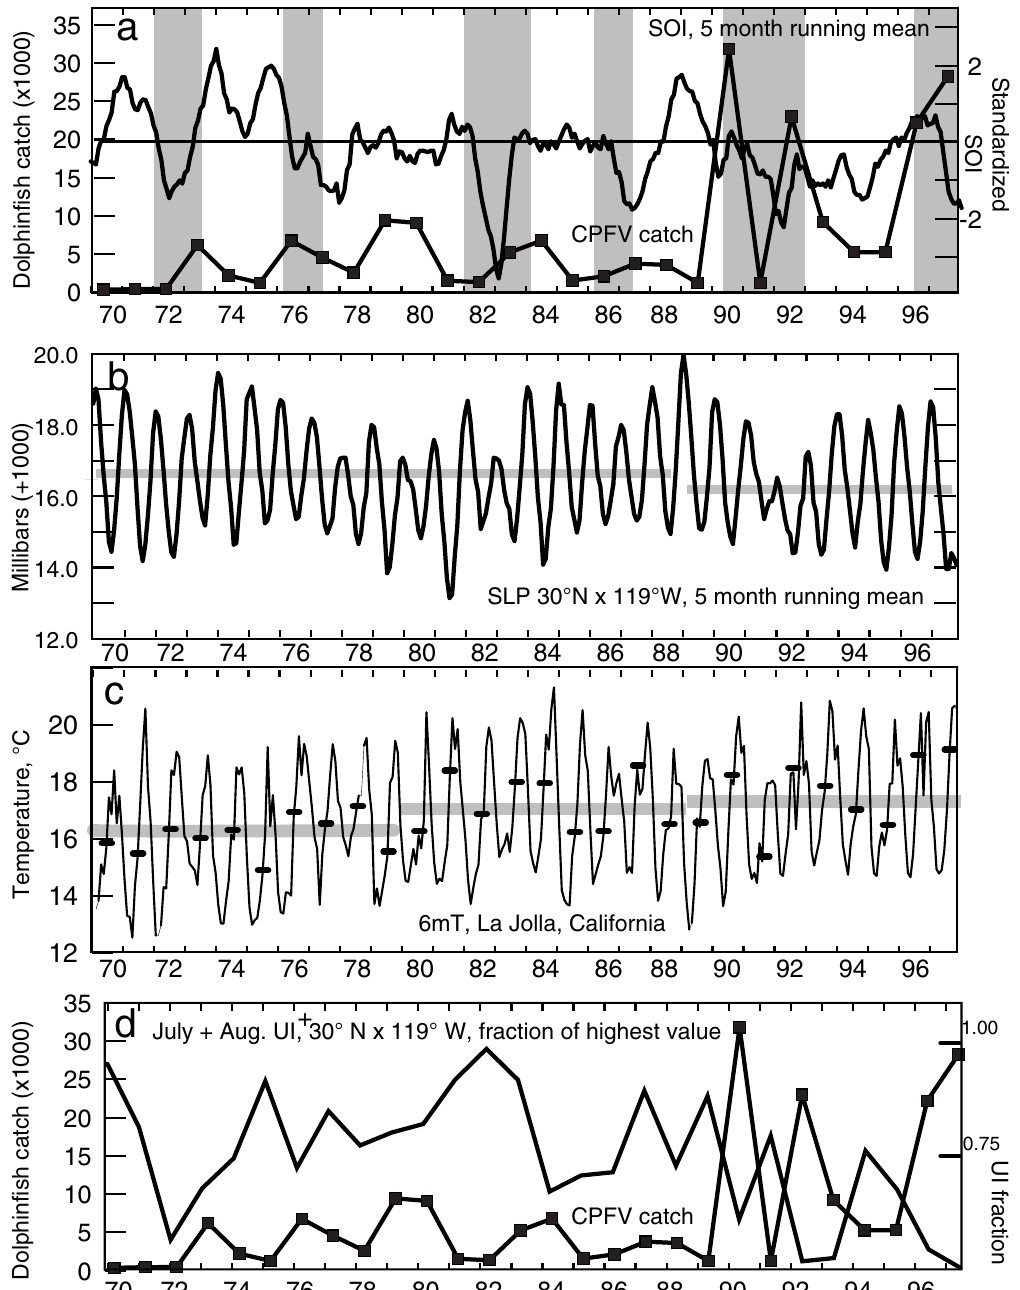
Southern Oscillation Index Relationships between the SOI, El Niño and dol- phinfish catch are shown in Figure 6a. The well